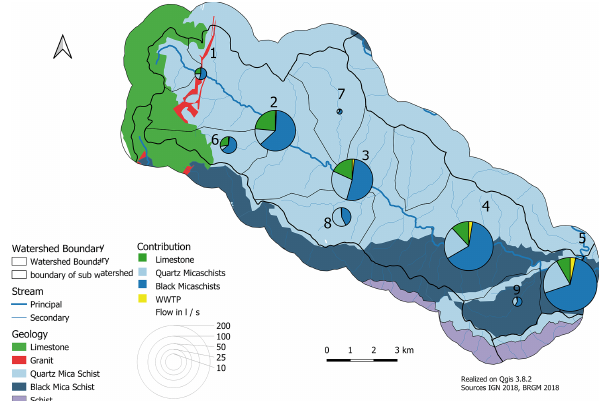
Figure 12. Map of the contributions of the different aquifers in the Gardon de Sainte-Croix basin on 11 October